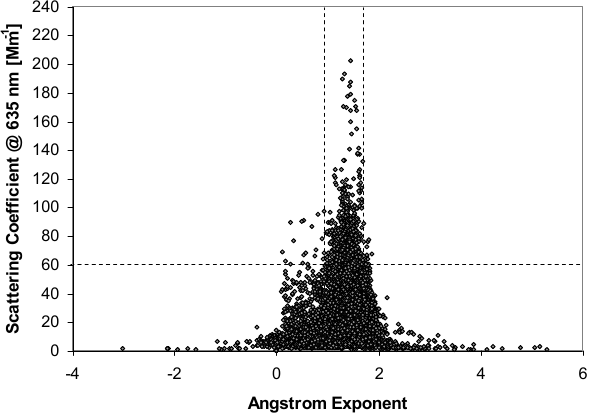
Fig. 5. Scattering coefficient distribution at 635nm as a function of the ˚Angstr¨om exponent values.